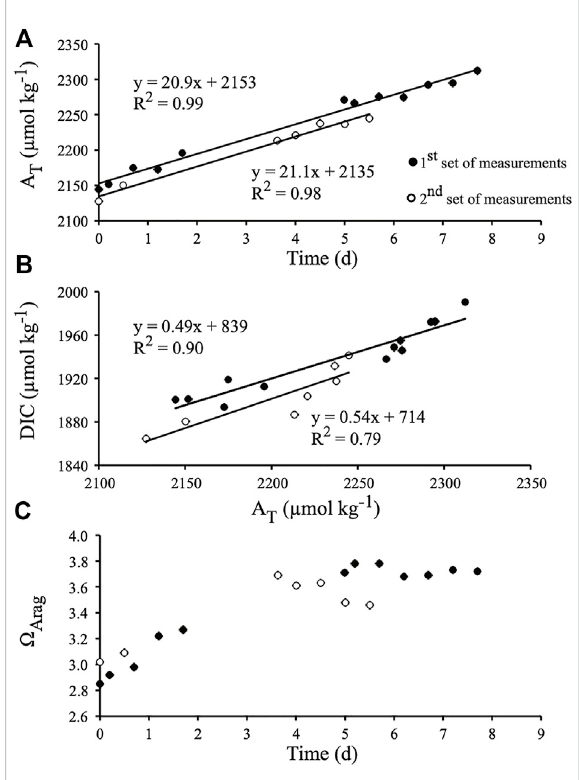
FIGURE 2 Chemical parameters recorded during the fi rst experiment, i.e., during the indoor fl ume experiment under controlled light (350 µmol photons m − 2 s − 1 , Hawaii). (A) Total alkalinity (A T ) monitored over time. (B) Dissolved inorganic carbon (DIC) versus A T . (C) Evolution of the saturation state of aragonite ( over the course of the experiment. The equation of each slope is provided as well as its determination coef fi cient (R 2